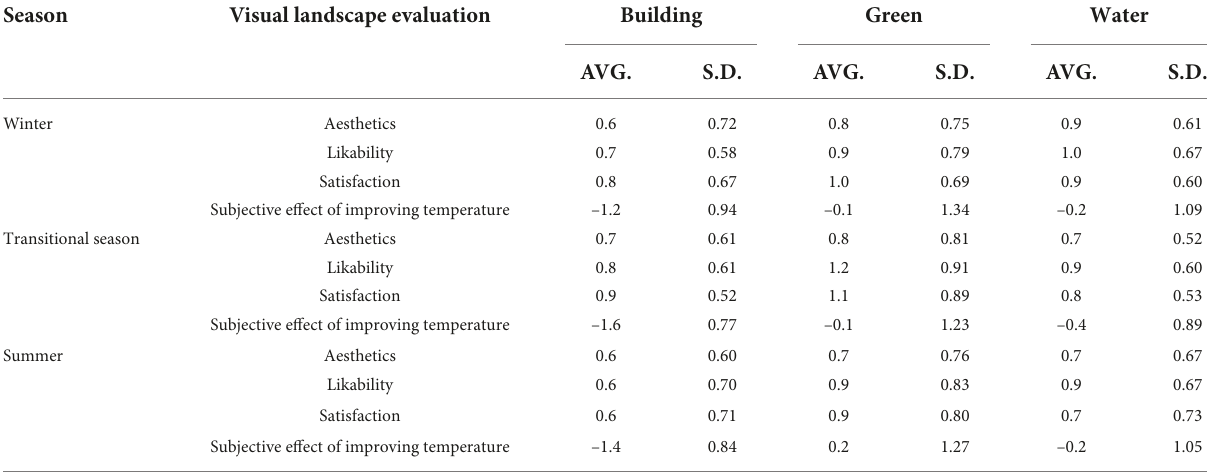
TABLE 8 Visual landscape evaluation results.